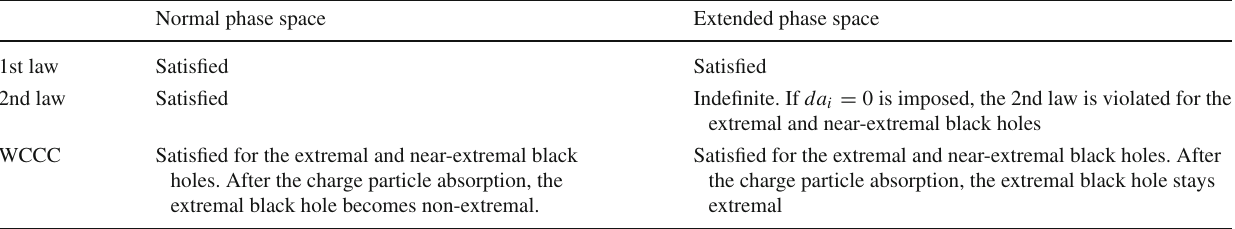
Table 1 Results for the first and second laws of thermodynamics and the weak cosmic censorship conjectures (WCCC), which are tested for a general NLED charged AdS black hole with absorbing a charged particle in the test particle limit Normal phase